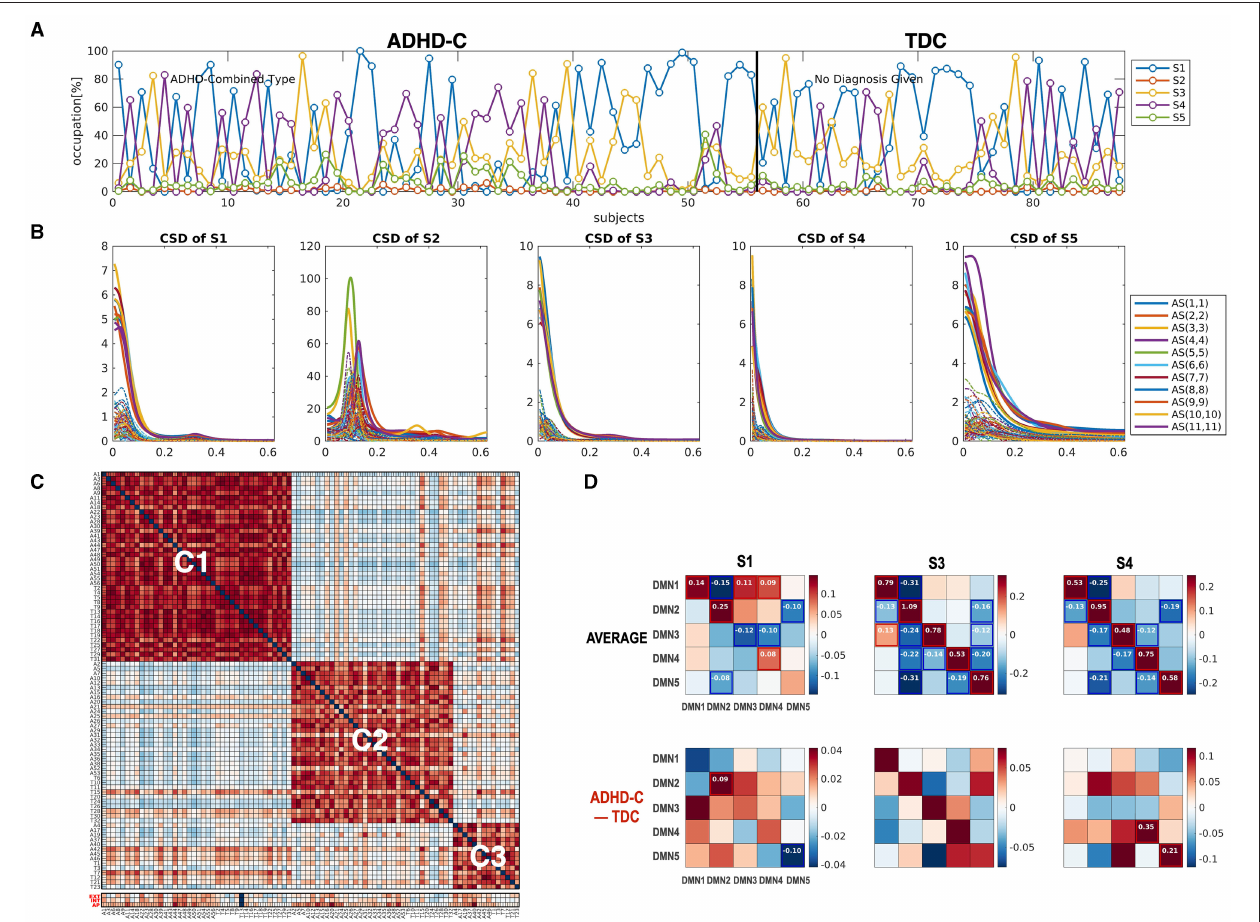
FIGURE 10 | The state-dependent connectivity at the DMN with the whole brain connectivity as a state sequence. (A) The state distribution according to the whole-brain functional connectivity occupation indices and (B) the cross-spectra for each state, derived from the HMM-MAR of the whole brain time series, are displayed. (C) The modularity optimization of the similarity matrix of individuals according to the state occupation indices of the whole brain clustered individuals into three subtypes regardless of diagnostic groups. (D) The group average and group-difference in the state-dependent effective connectivity at the DMN (ADHD-C – TDC) are presented to show the state-dependent DMN effective connectivity according to the state of the whole-brain connectivity. Not many group differences exist for state-dependent connectivity when ADHD-C and TDC are analyzed as a whole. This calls for a subtype-level comparison of the groups, as shown in Figures 8 , 9